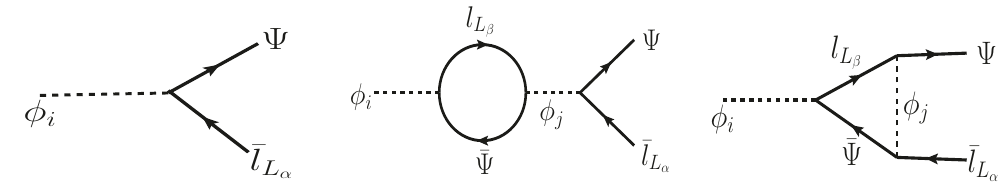
Figure 8 . Possible feynman diagrams for lepton asymmetry production from singlet scalar